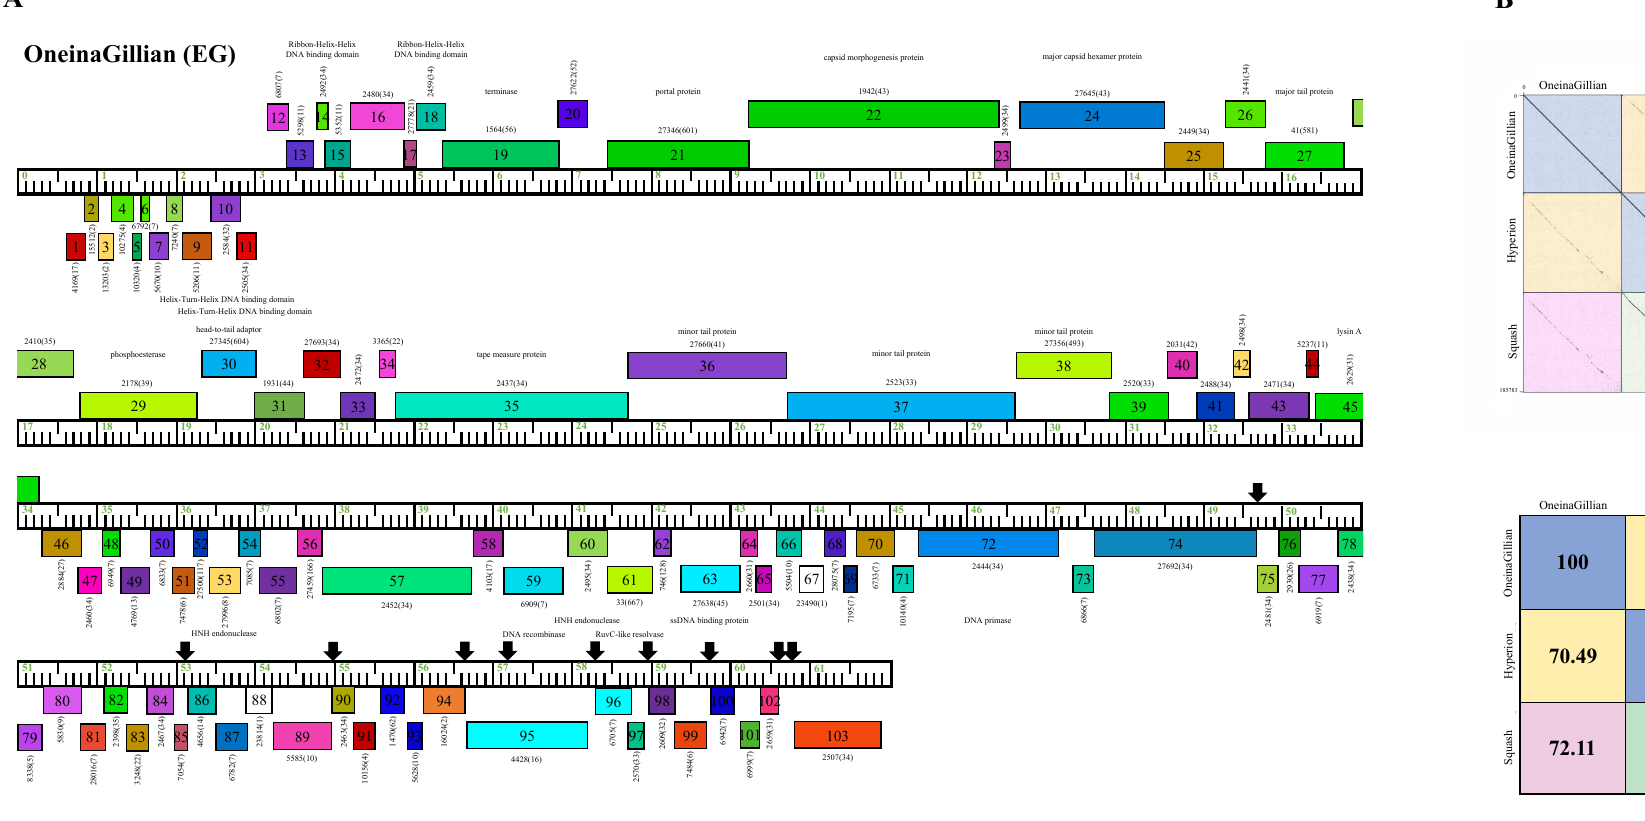
Figure 7. Genomic organization of Microbacterium Cluster EG phage OneinaGillian. ( A ) Whole genome organization of phage OneinaGillian. Genes are represented as boxes above or below the genome, reflecting rightwards or leftwards transcription, respectively. The phamily number, along with the number of members in the specific phamily in parentheses, are also written above or below the boxes. Black down arrows indicate the positions of a conserved 18 bp short inverted repeat motif. ( B ) Dot plot and percent identity comparisons of OneinaGillian to two other Cluster EG phages, Hyperion and